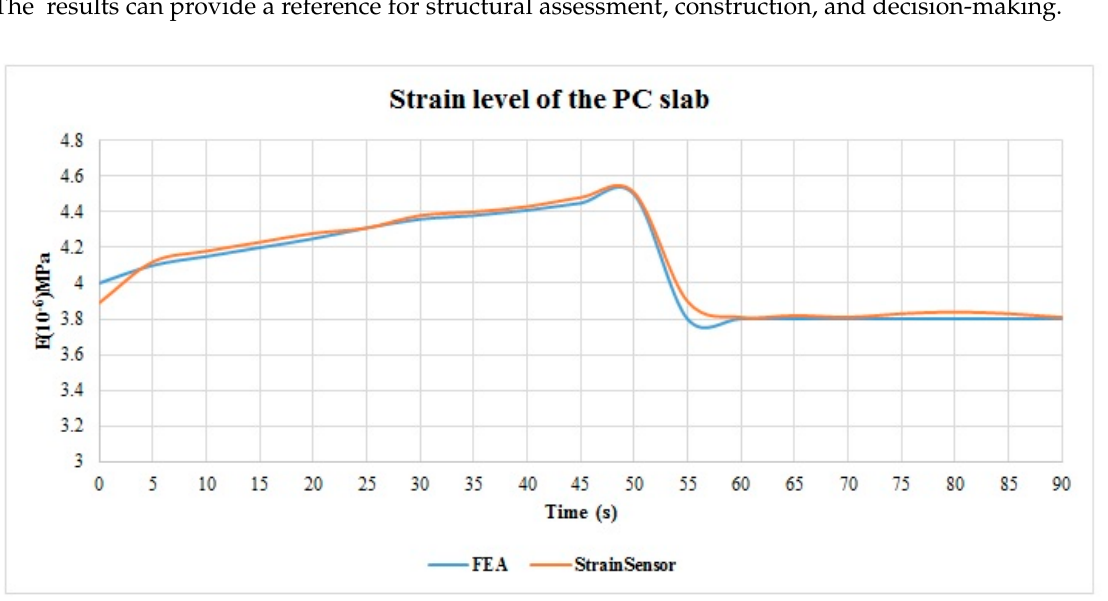
Figure 22. The strain level results of a PC slab obtained from FEA analysis and sensor monitoring.